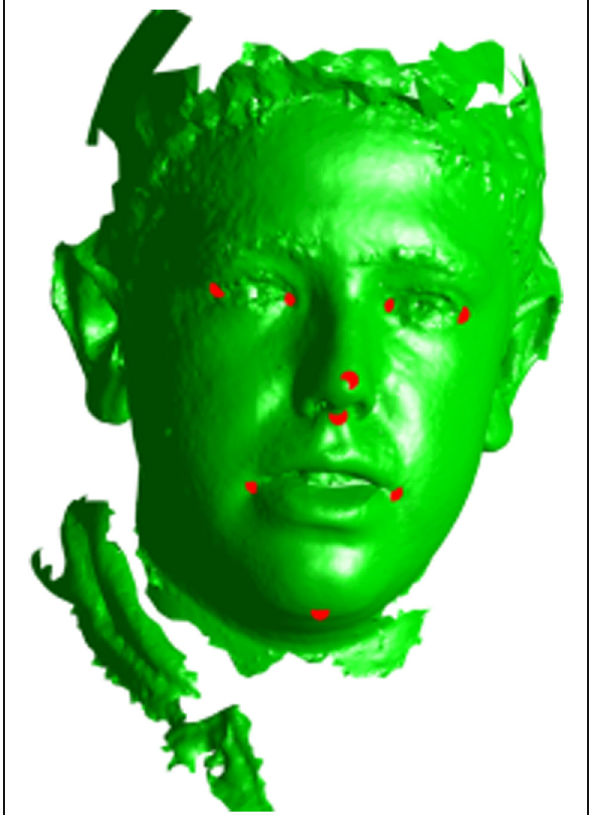
Fig. 1 Nine facial landmarks used for global alignment (left eye outer, left eye inner, right eye outer, right eye inner, nose tip, nose base middle, mouth left corner, mouth right corner, chin